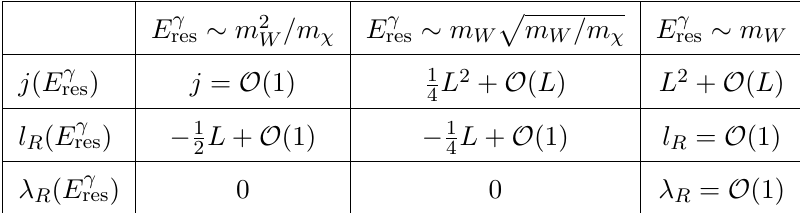
-dependent functions appearing in the fixed- res -scales relevant to figure 8. Vanishing entries are res